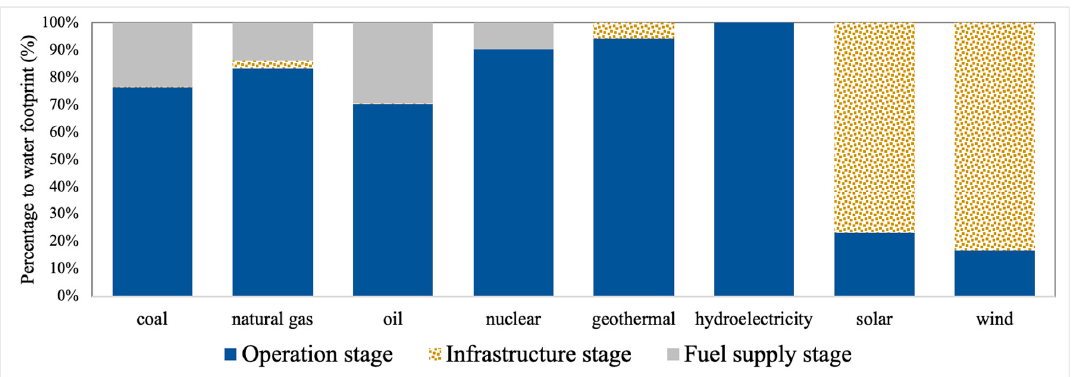
Figure 4. Percentage contributions of life-cycle stages to water footprints in power generation (Data are extracted from [33]).